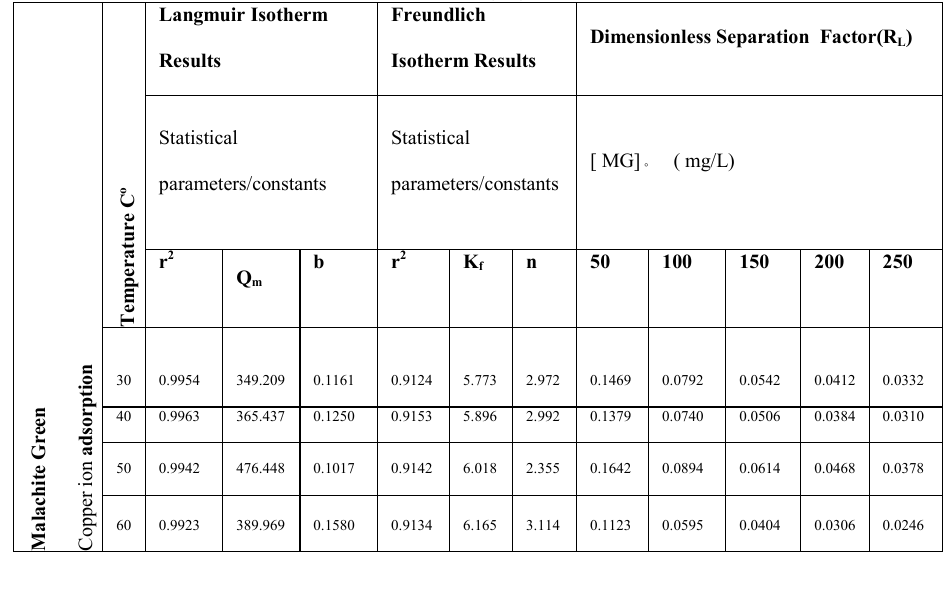
Table 3. Langmuir Isotherm, Freundlich Isotherm results and Dimensionless separation